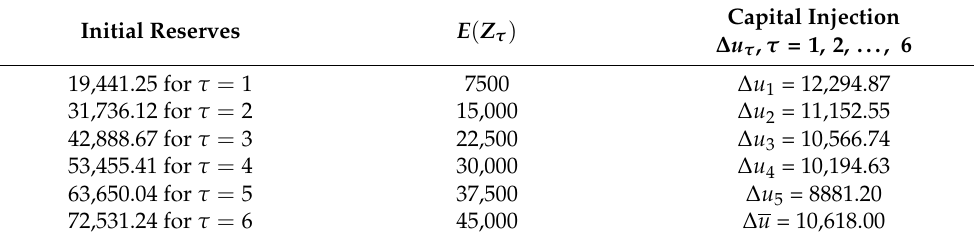
Table 12. P ( T < τ | T < ∞ ) = 0.01, surplus 45,000.